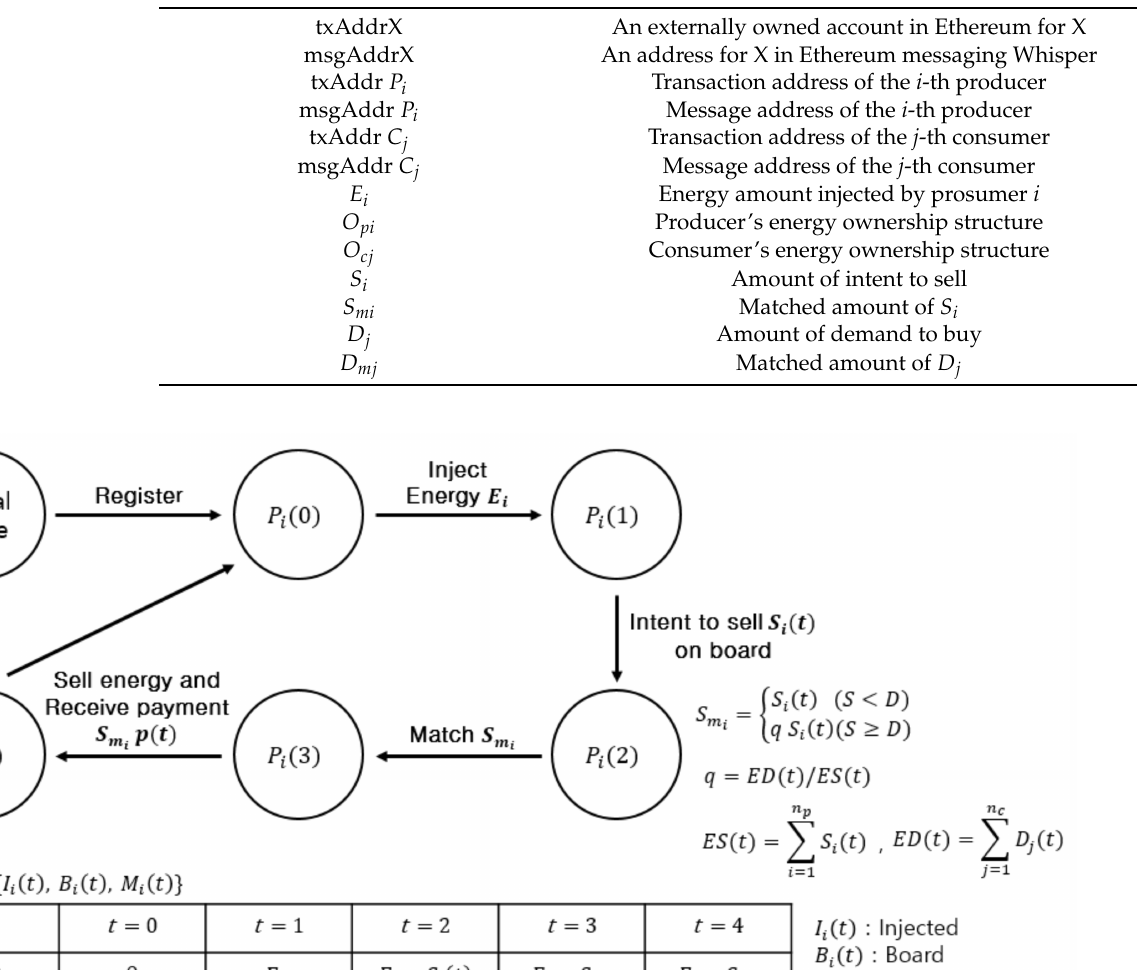
Table 1. Notations for energy trading algorithm.